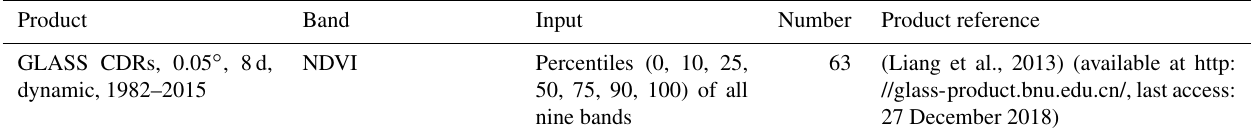
Table 2. The explanatory table of the constructed input data collection ∗ . Product Band Input Number Product reference (Liang et al., 2013) (available at http: GLASS CDRs, 0.05 ◦ , 8d, NDVI Percentiles (0, 10, 25, //glass-product.bnu.edu.cn/, last 50, 75, 90, 100) of all